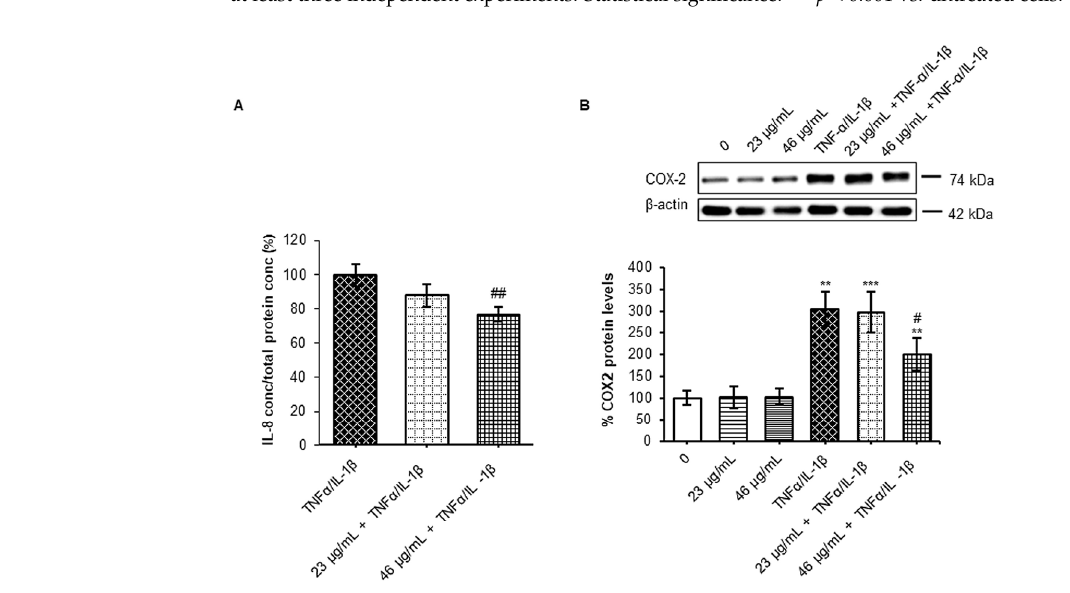
Figure 6. Evaluation of NFKB targets. Caco-2 cells, cultured on Transwell inserts for 21 days, were exposed to pro-inflammatory cytokines (TNF α 10 ng/mL + IL-1 β 5 ng/mL) for 24 h after a 24 h pre-treatment with two different concentrations in polyphenols of digested cinnamon extract (23 and 46 µ g/mL). Then, cell lysates and basolateral media were harvested. ( A ) IL-8 secretion was evaluated by ELISA assay. Data were normalized by cell total protein concentration. Results reported in histograms are expressed in relative terms to inflammatory treatment and are shown a mean ± SE from at least three independent experiments. Statistical significance: ## p < 0.01 vs. TNF α /IL-1 β . ( B ) COX-2 protein levels were analyzed by SDS-PAGE electrophoresis and Western blotting. COX-2 was detected with a specific antibody and revealed by enhanced chemiluminescence (ECL). Samples were normalized on β -actin immunoreactivity. Histograms, obtained from at least three distinct experiments, represent the percentage of protein levels with respect to untreated cells as mean ± S.E. Statistical significance: ** p < 0.01 and *** p < 0.001 vs. CTRL and # p < 0.05 vs. TNF α /IL-1 β